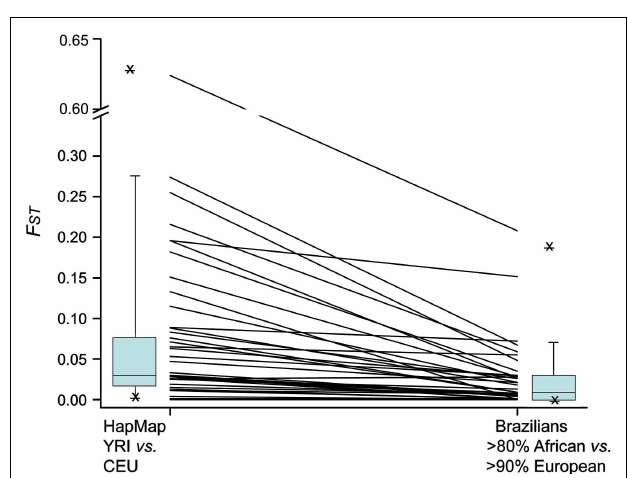
FIGURE 7 |Allele-specific F ST values for 38 PGx polymorphisms in HapMap CEU vs.YRI and in Brazilians with > 90% European ancestry vs. Brazilians with > 80%African ancestry. The lines connect the F ST values for each polymorphism in the two data sets and the box plots at the left and right summarize the ensemble of the data for each